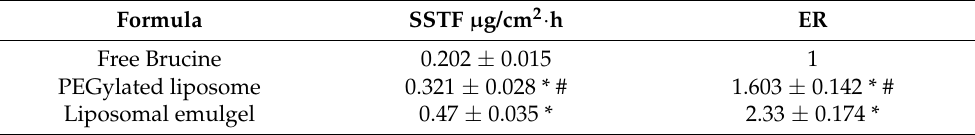
Figure 9. Outline of ex vivo permeability study of Brucine from diverse preparations through rat skin membrane. Results are identified in respect of mean ± SD (n = 3). * ( p < 0.05) compared to free ± SD (n = 3). * ( p < 0.05) compared to free Brucine; # compared to PEGylated liposome formulation. skin membrane. Results are identified in respect of mean Brucine; # compared to PEGylated liposome formulation. Table 4. Skin permeation parameters of different developed